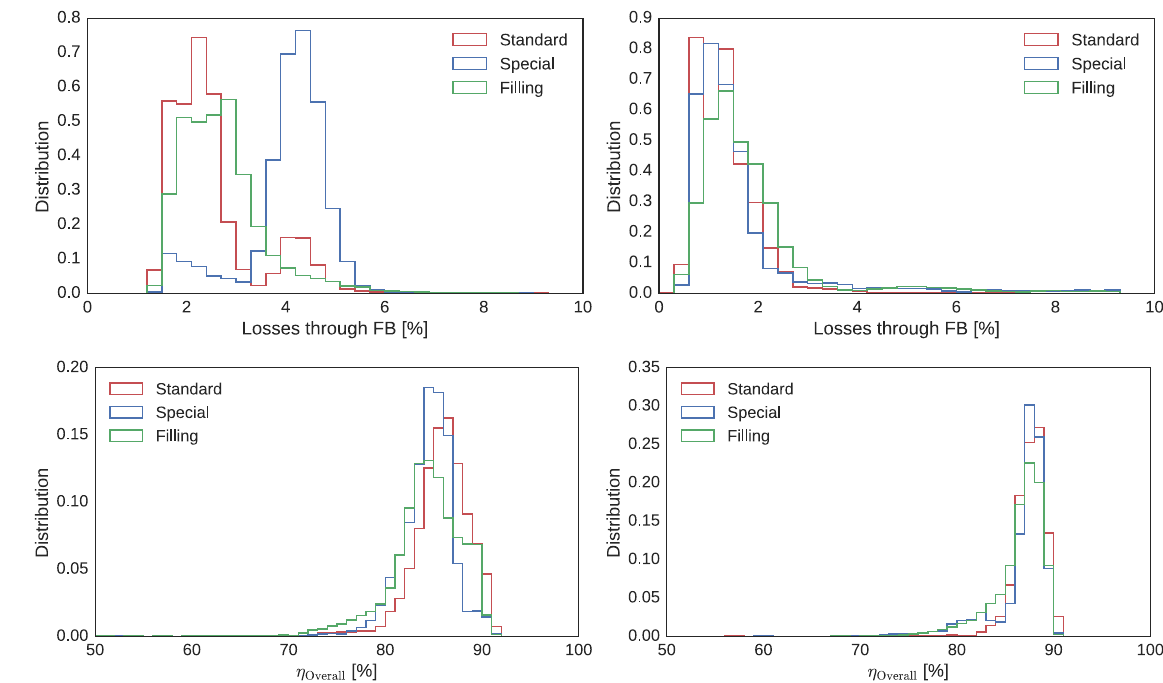
FIG. 20. Transmission efficiency η (upper row) and η (bottom row) for MTE (left column) and CT (right column) for the FB Overall various types of SPS super-cycles (Standard for the normal super-cycle; Special for super-cycle for beam physics development studies; Filling for LHC filling super-cycle). The difference is clear and mainly stems from the different efficiency in the low-energy part of the SPS cycle.